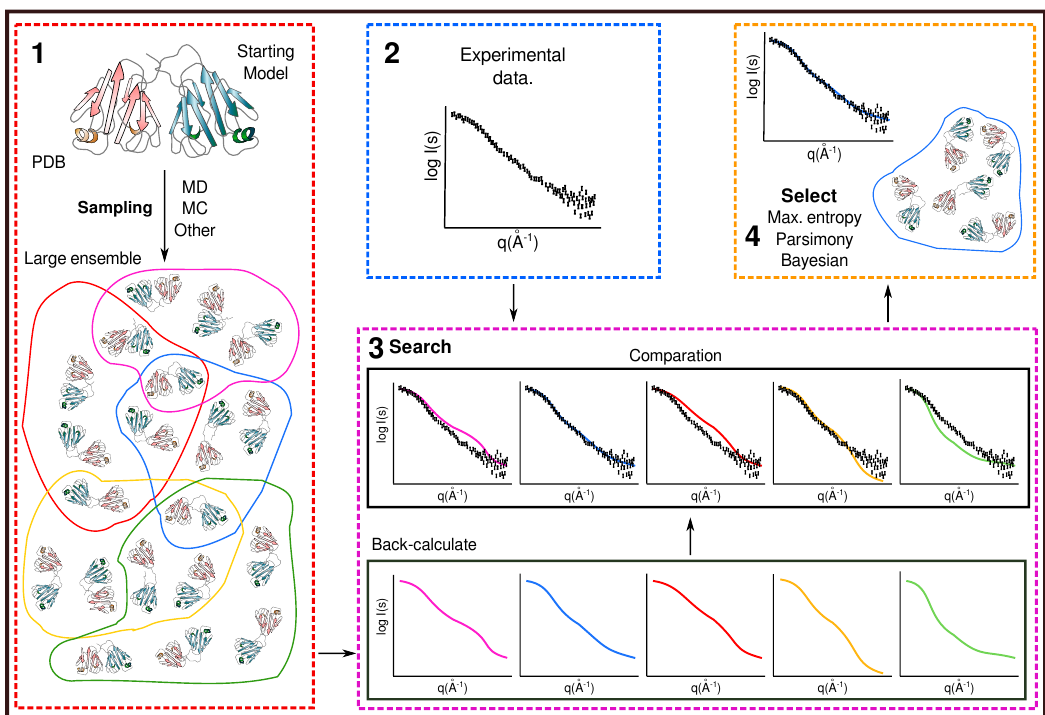
Figure 2. Schematic representation of the di ff erent steps in the search and select approach. (1) First, the computational sampling protocol is performed to generate a large pool of di ff erent